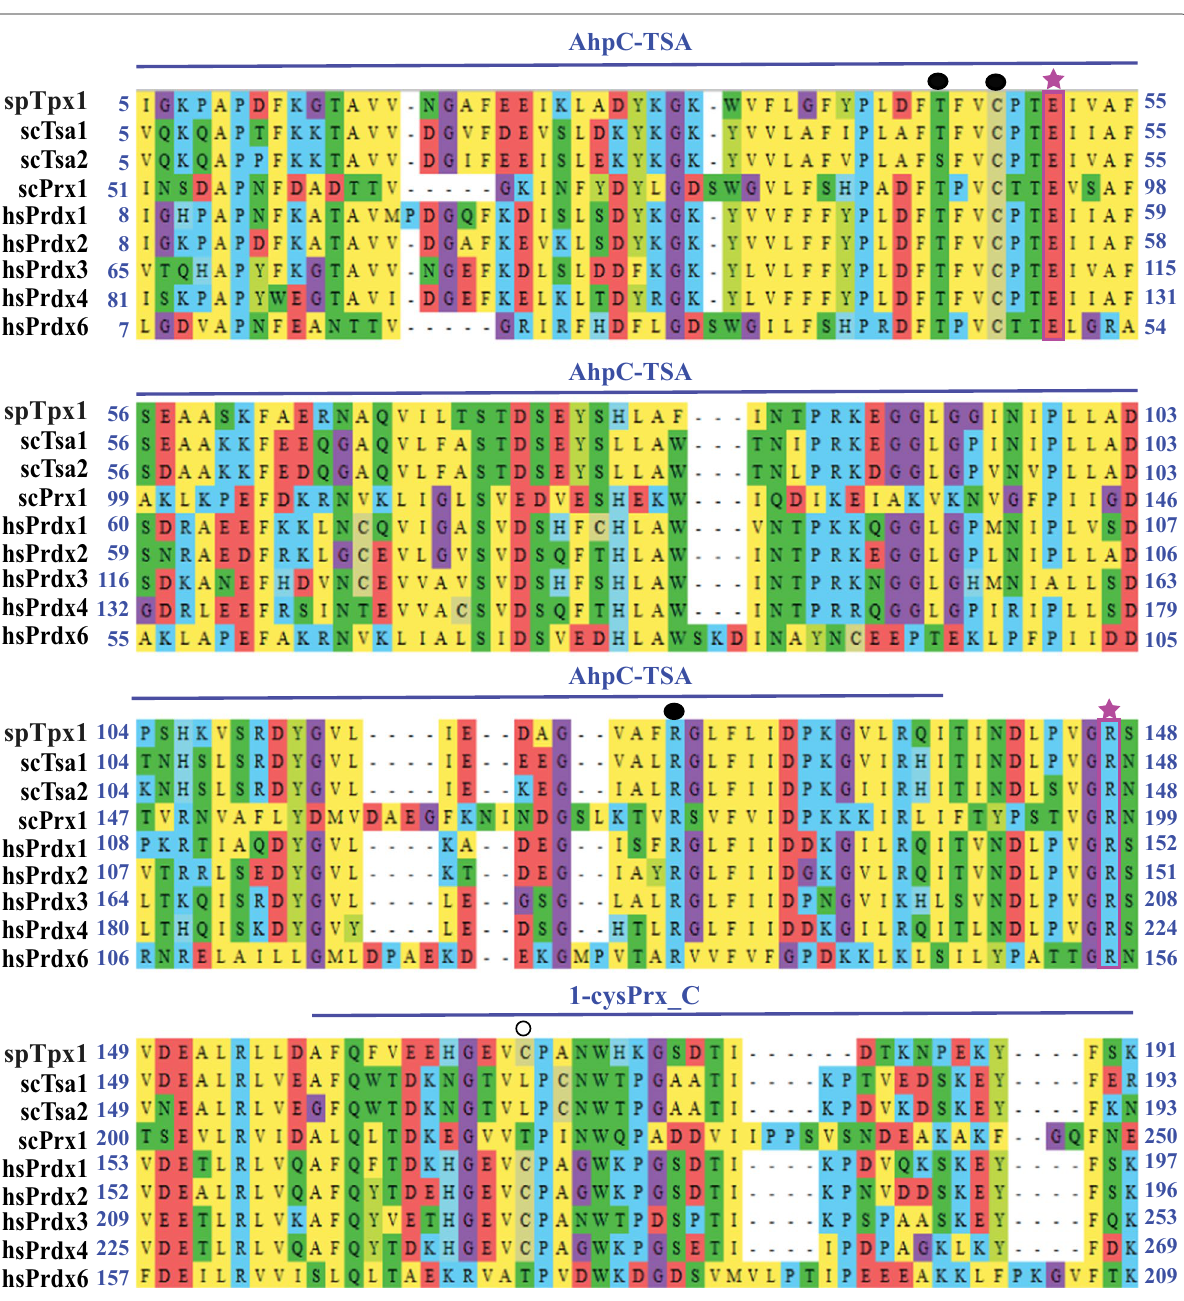
Fig. 4 Multiple sequence alignment of TPxs from S. pombe , S. cerevisiae and humans. The alignment was constructed using the MEGA_X_10.1.8 software. The N-terminal AhpC-TSA domain and C-terminal 1-Cys Prx_C domain which are characteristic of Prxs were identified by searching the SMART database. The catalytic triad (Thr/Ser-Cys-Arg), the resolving residue and the Glu and Arg residues involved in Prx-Trx interaction are indicated by filled cycles, open circles and stars, respectively. Amino acid residues are highlighted according to the biochemical properties of